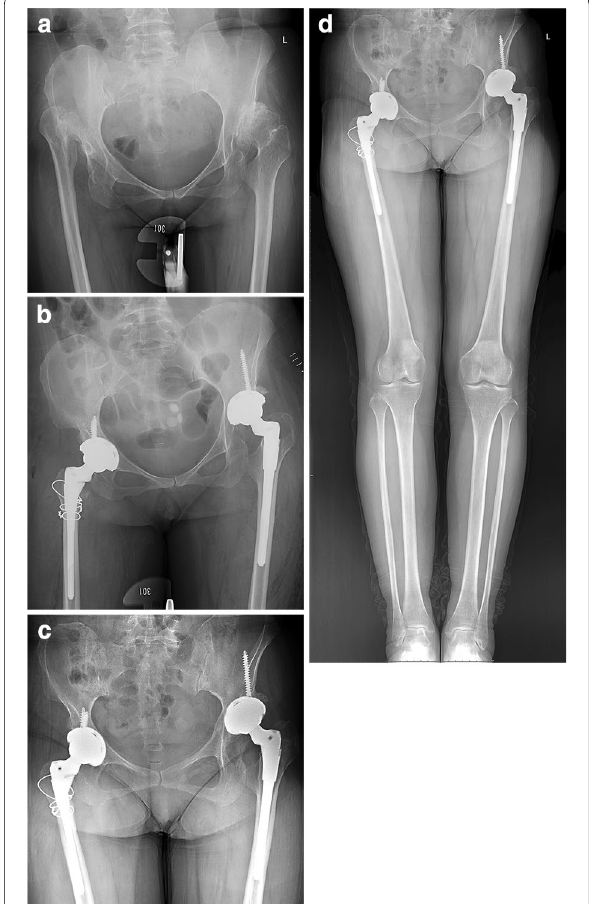
Fig. 4 Preoperative anterior–posterior X-ray highlighting a bilateral DDH (right hip as Crowe IV and left hip as Crowe III) in a 49-year-old female patient ( a ). Postoperative X-ray showing an asymmetrical reconstruction of the Crowe III hip with high hip center and the Crowe IV hip at the anatomical position ( b ). SSTO was performed in the Crowe IV hip, and the osteotomy length was 3.5 cm. At final follow-up, radiographic evaluation after 3.5 years showing no loosening ( c ). Full-length standing anteroposterior radiograph showing that both lower limbs were of equal length ( d